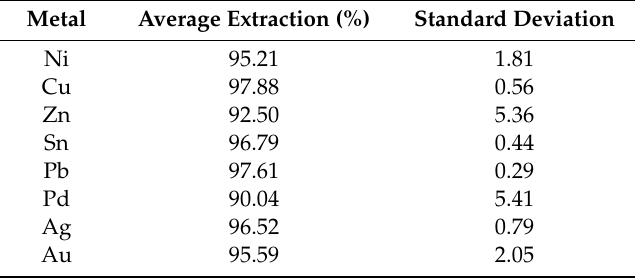
Table 8. Triplicate leaching results under optimal conditions.